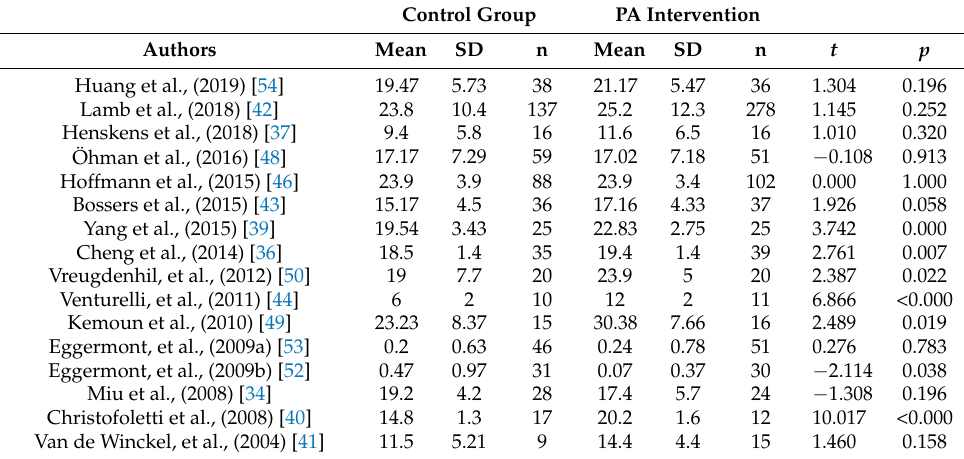
Table 2. Summary measures (Mean, SD, t , and p of MMSE